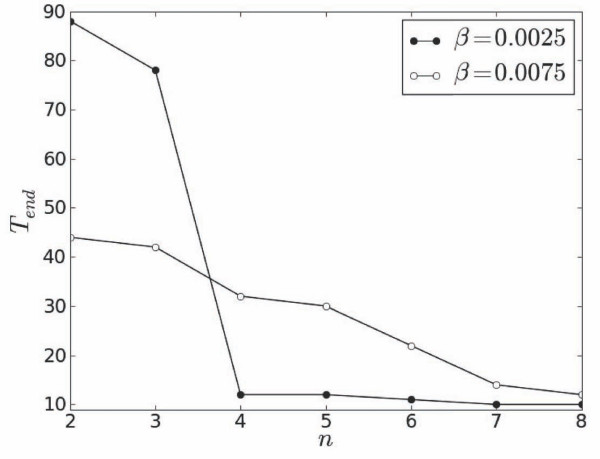
Dependencies of Tend on n for different β, α = 0.67 and x=L2.